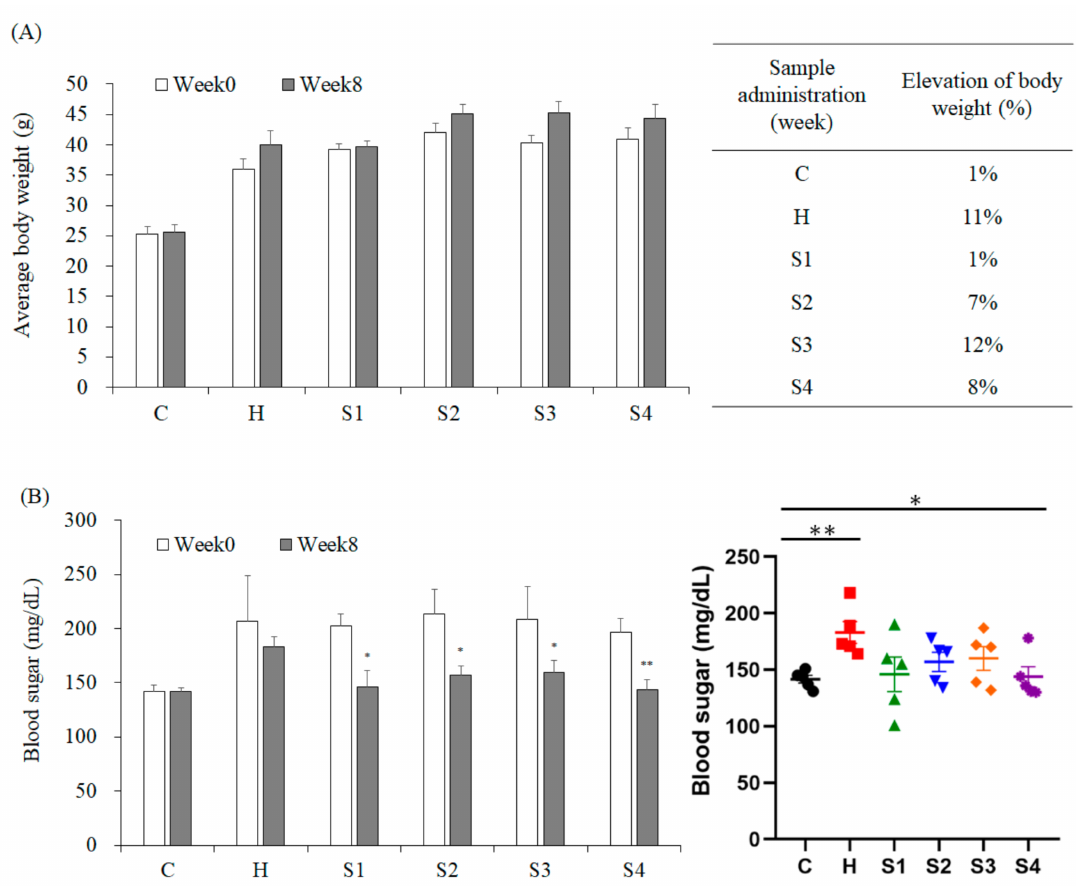
Figure 3. The effects of C. militaris on body weight and blood sugar in mice fed a high-fat/sucrose diet. ( A ) Total body weight and body weight gain of mice after treating with samples for 8 weeks. ( B ) The levels of blood sugar in the serum of high-fat/sucrose diet-fed mice after 8-week treatment. Data are shown as means ± SEM ( n = 5). * p < 0.05, ** p < 0.01 compared to the control group.